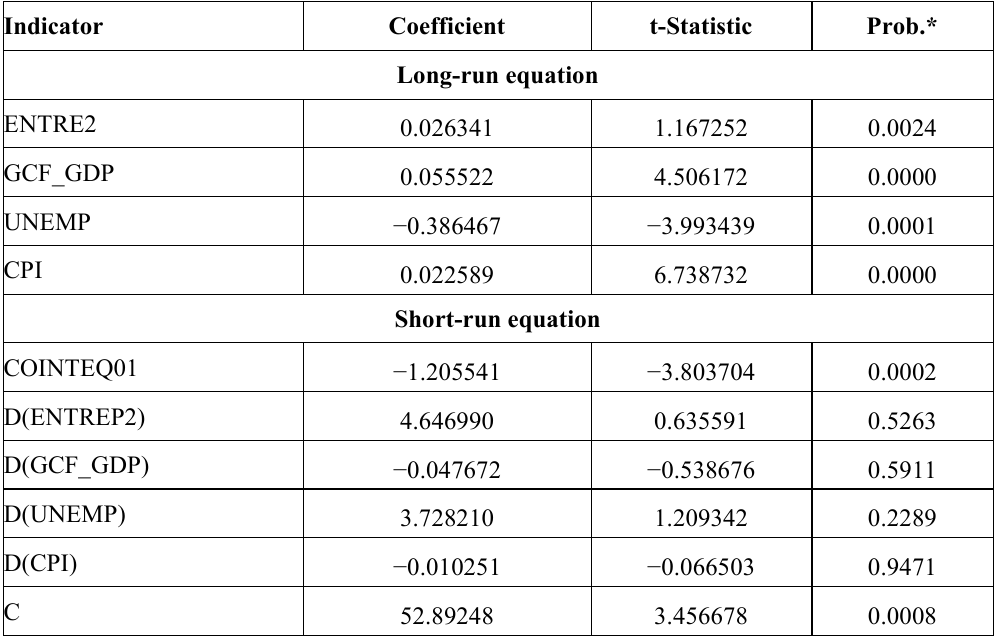
Table 5. Robustness